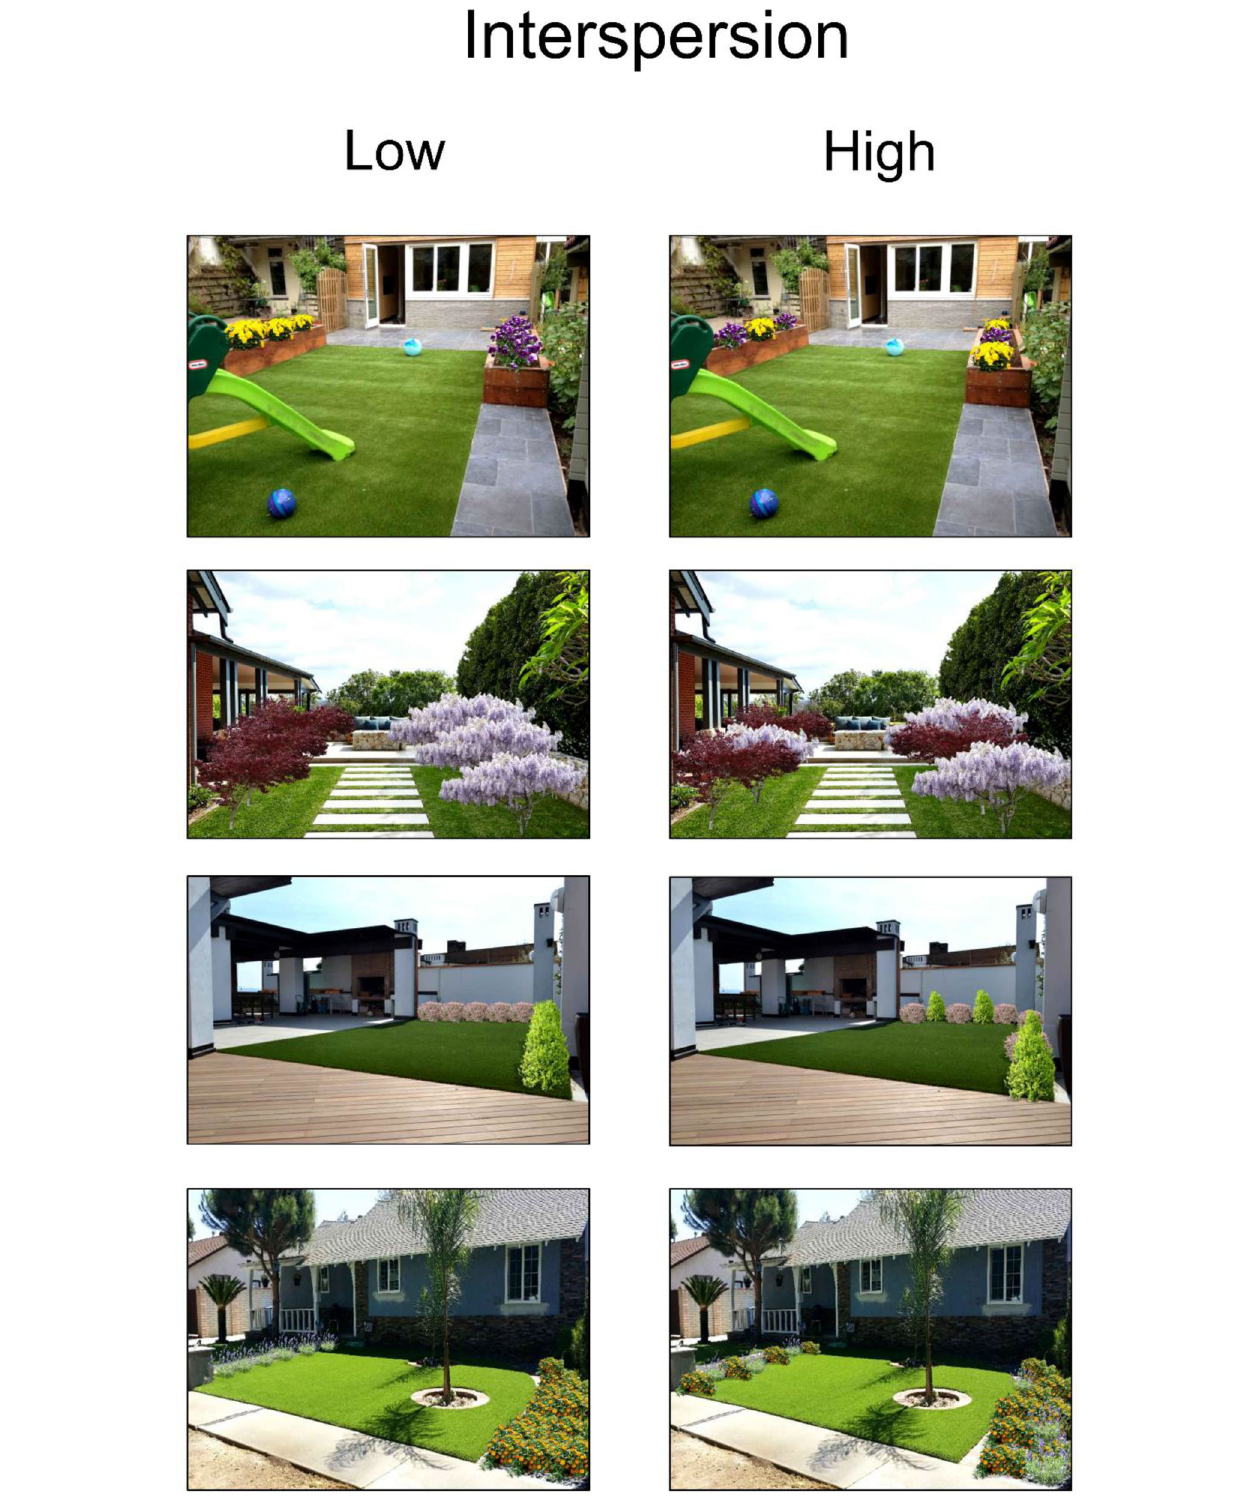
FIGURE 2 | Examples of landscape pairs with low and high varietal interspersion. Images created with Realtime Landscaping Architect. Reproduced with permission.